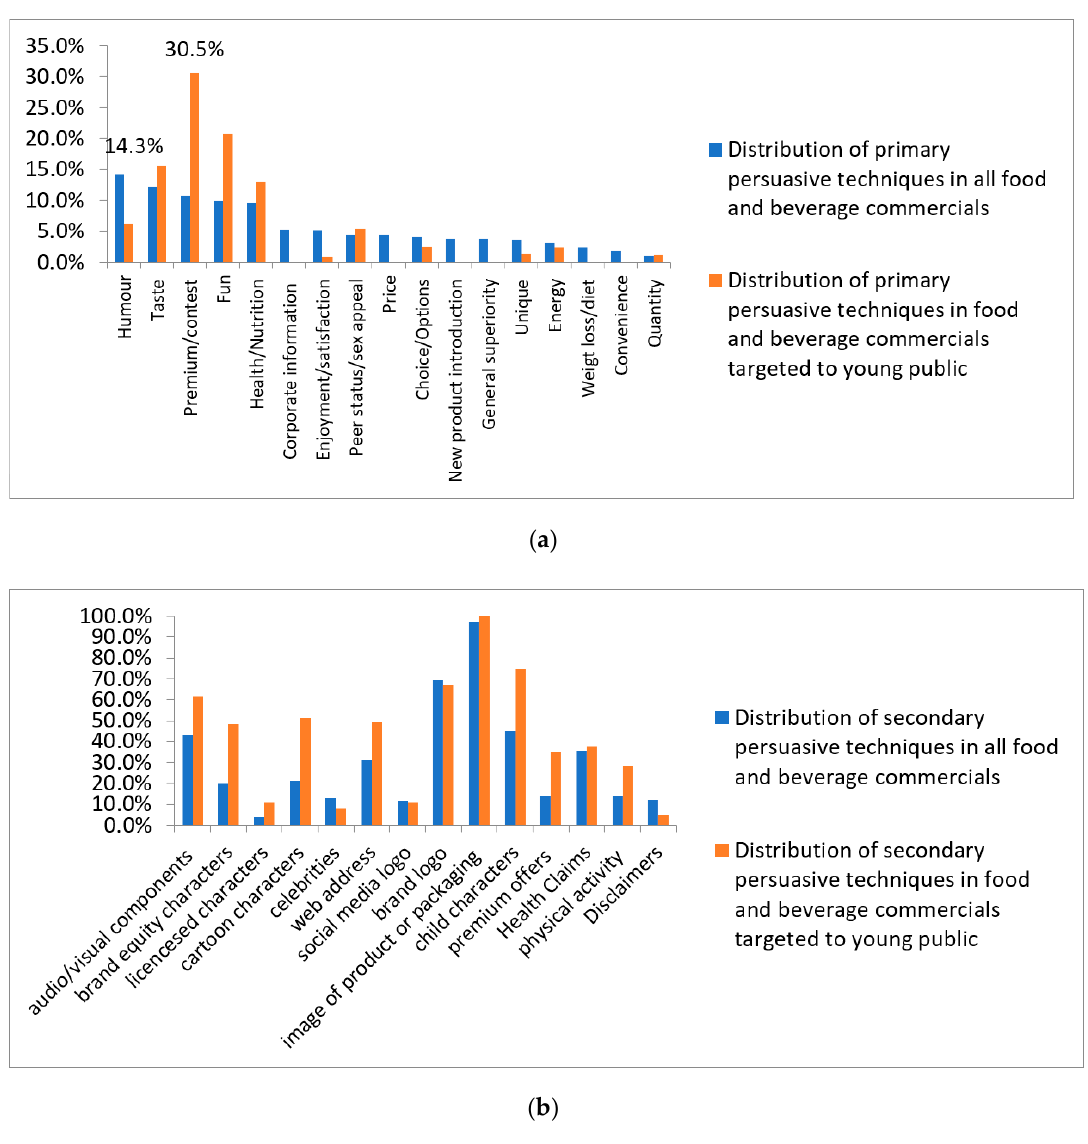
Figure 2. ( a ) Distribution of primary persuasive techniques and ( b ) of secondary persuasive techniques among food and beverage commercials.